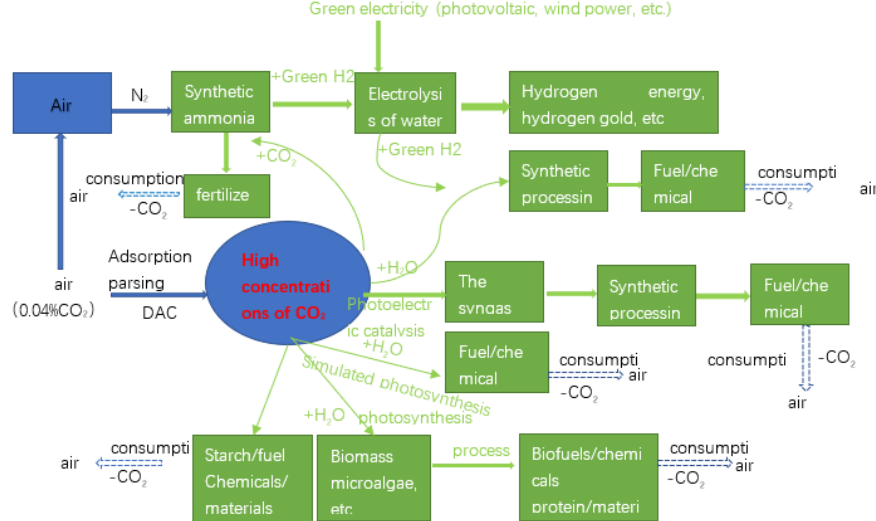
Figure 1. Schematic diagram of a CO 2 chemical system with zero carbon emissions.